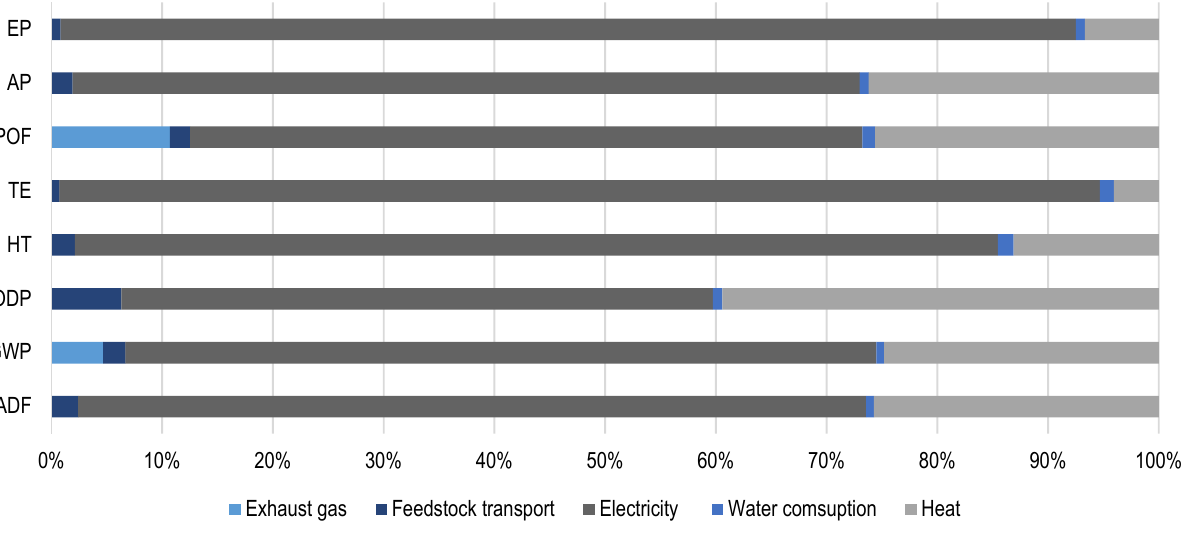
Figure 7. Contribution of the primary environmental aspects on the impact categories.